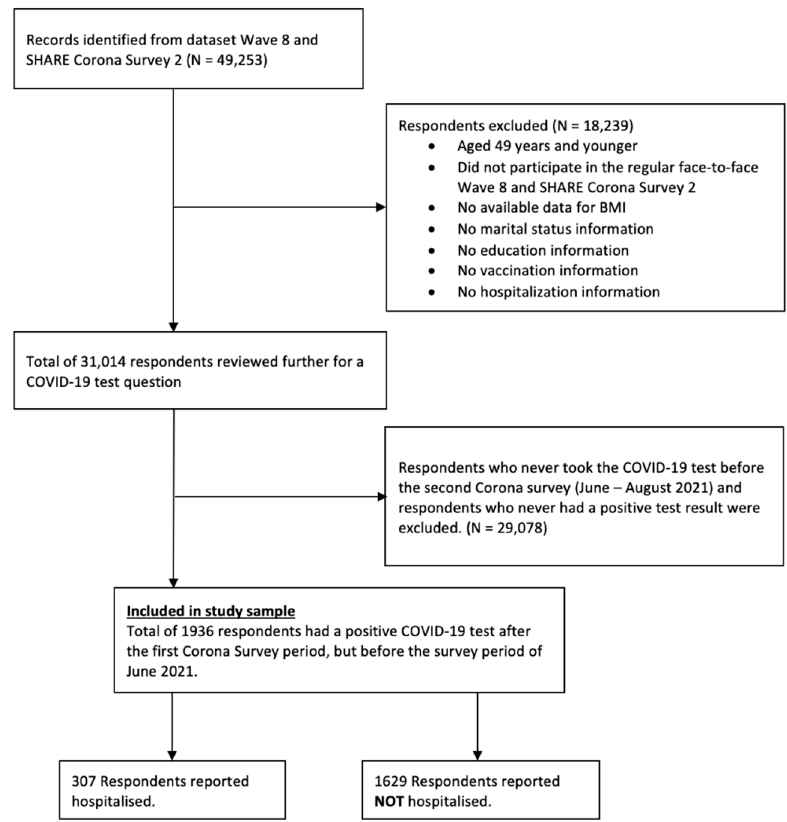
Figure 1. Flowchart showing selection of study sample.